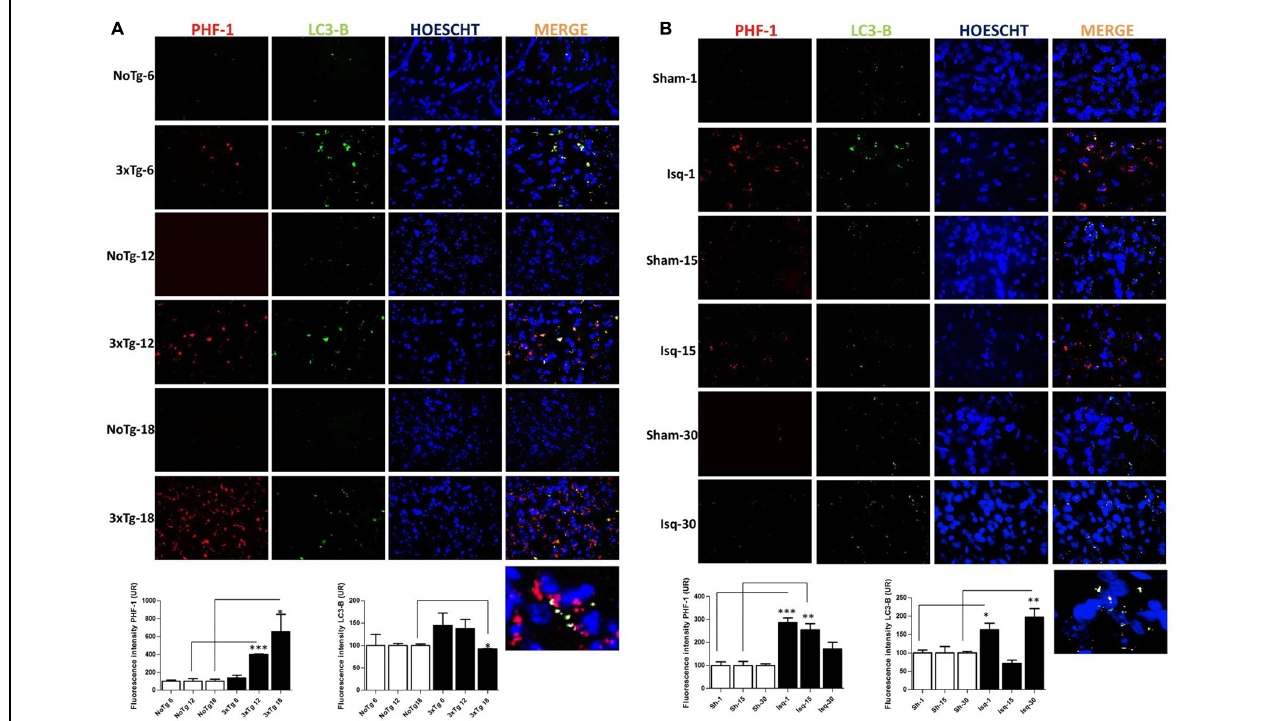
FIGURE 6 | LC3B and PHF-1 immunofluorescence in the cerebral cortex of 3xTgAD mice and in cerebral ischemic rats. LC3B and PHF-1 immunofluorescence was detected in the SS-Cx of 3xTgAD mice and cerebral ischemic rats. (A) PHF-1 fluorescence intensity increased in 3xTg-AD mice at 12 ( p ≤ 0.0003) and 18 months ( p ≤ 0.0233), and LC3B fluorescence intensity decreased in 3xTg-AD mice at 18 months ( p ≤ 0.0499). (B) PHF-1 fluorescence intensity increased at 1